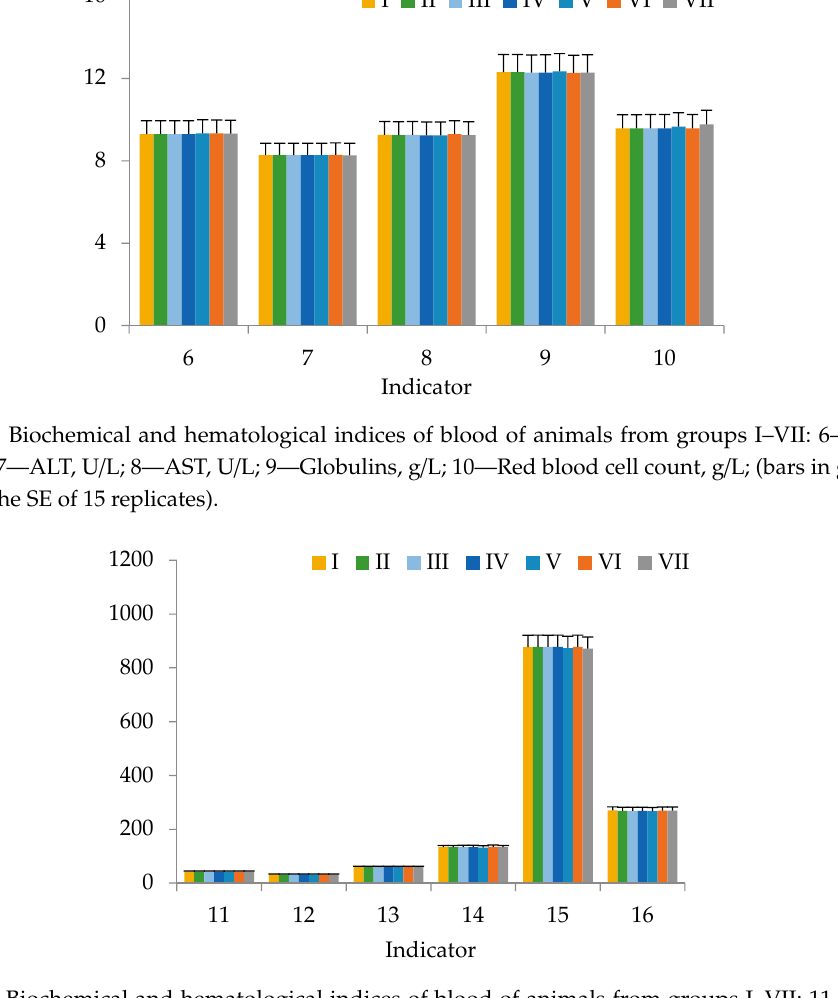
Figure 3. Biochemical and hematological indices of blood of animals from groups I–VII: 11—Total protein, g / L; 12—Albumin, g / L; 13—Creatinine, µ mol / L; 14—Hemoglobin level, g / L; 15—Platelet count, g / L; 16—Average concentration hemoglobin in the erythrocyte, g / L (bars in graphs indicate the SE of 15 replicates).